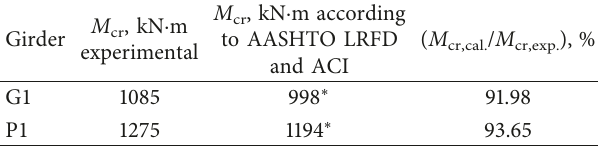
cr values for girders G1 and P1.